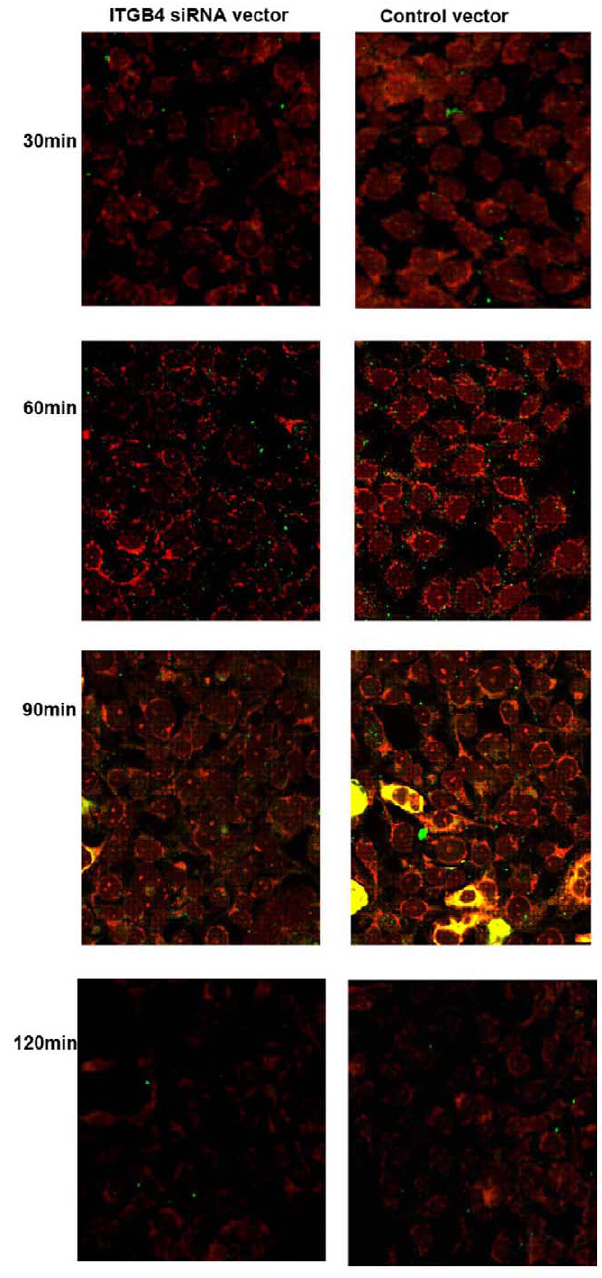
Figure 2. Colocalization of HLA-DR with endocyosed OVA in respiratory epithelial cells. 16HBE14o- cells from different groups were pulsed with FITC-labeled OVA for 0–120 min, fixed, permeabilized, and stained with Dylight 549-labeled anti-HLA-DR antibodies. Cells were analyzed by confocal microscopy. Yellow staining (red + green) indicates colocalization. Results are representative of 1 experiment repeated 3 times. doi:10.1371/journal.pone.0032060.g002 inhibited in the 16HBE14o- cells transfected with ITGB4 siRNA virus vector (Figure 1.C). While compared with the control siRNA vector, there was no significant influence on the ITGB4 protein expression (P . 0.5, n= 6, ANOVA) (Figure 1.C). We observed no obvious changes in cell confluence or morphology.